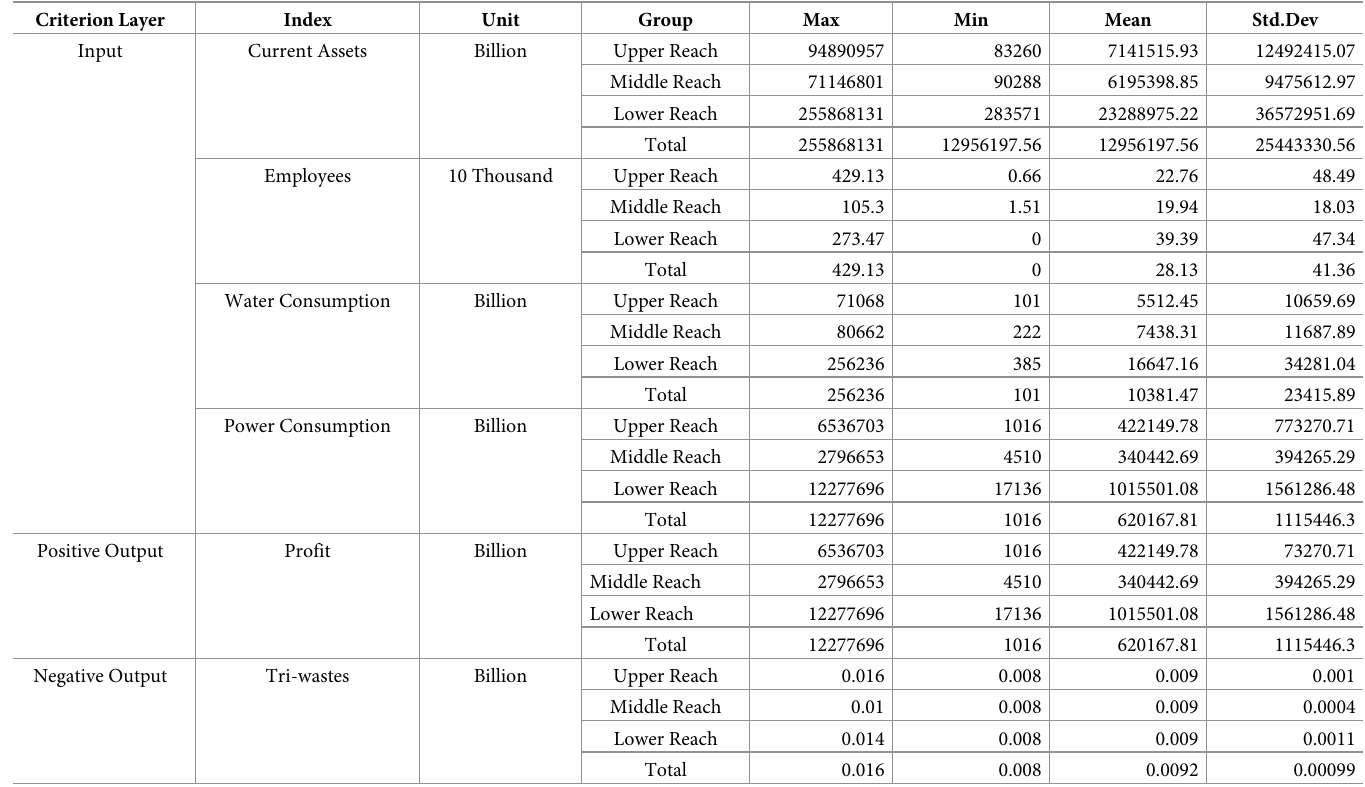
Table 2. Descriptive statistics of input and output indicators.